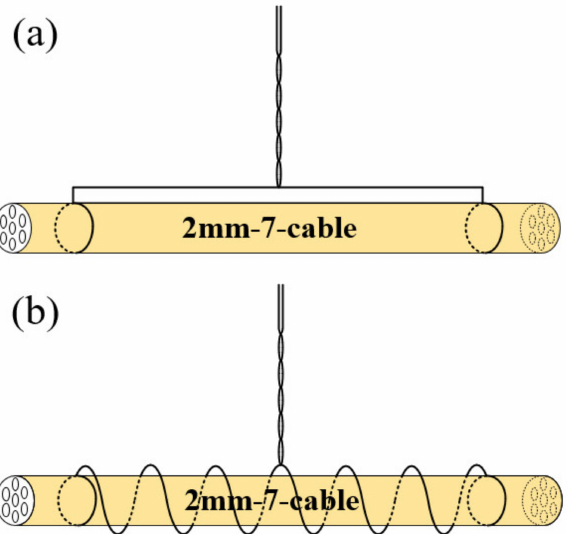
Figure 4. Schematic diagram of two voltage lead arrangements. ( a ) Square-lead arrangement; ( b ) Spiral-lead